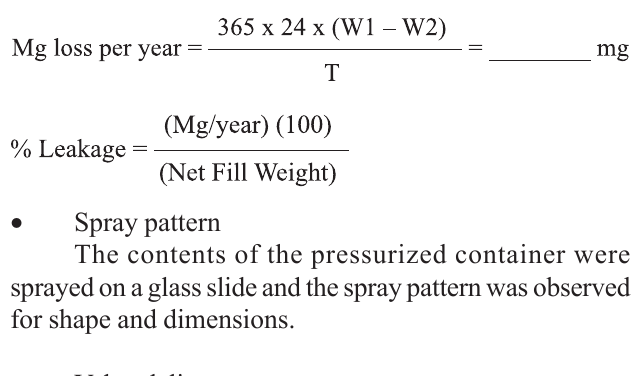
TABLE I - Physical properties of lactose grades used in DPI formulations